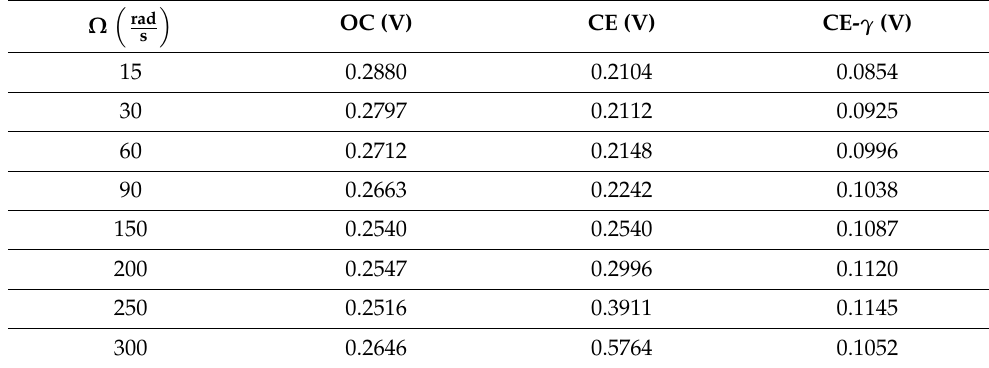
Figure 13. Calibration curves: ( a ) drive displacement, ( b ) sense displacement, ( c ) voltage output when 𝑅 = (cid:2869) , 𝑉 (cid:3002)(cid:3004) = 0.1𝑉 , 𝑉 (cid:3005)(cid:3004) = 1𝑉 , and 𝜇 = 0.01 . Table 3. Relative voltage error between SV and other models for different base rotations values.